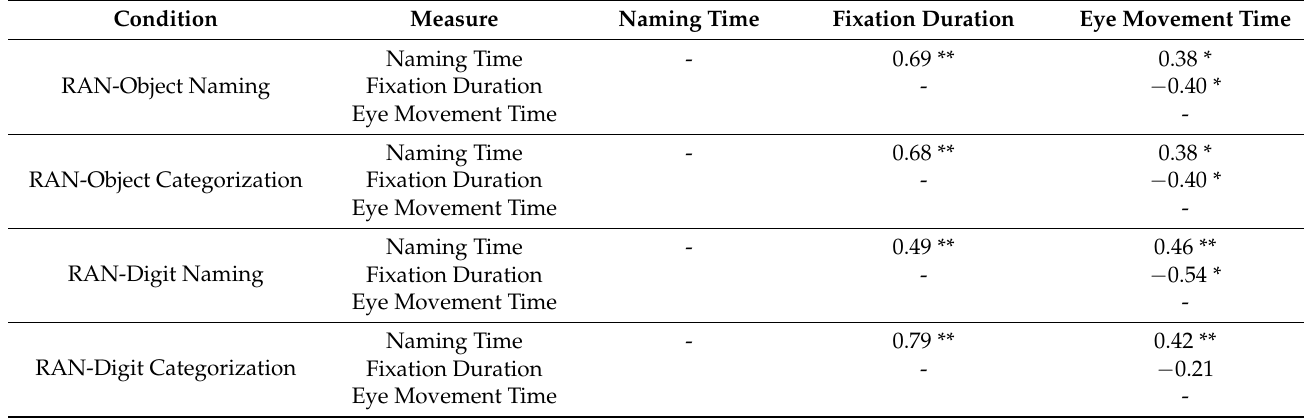
Table 8. Pearson’s correlation between naming times and eye movement variables within the same RAN-related tasks.